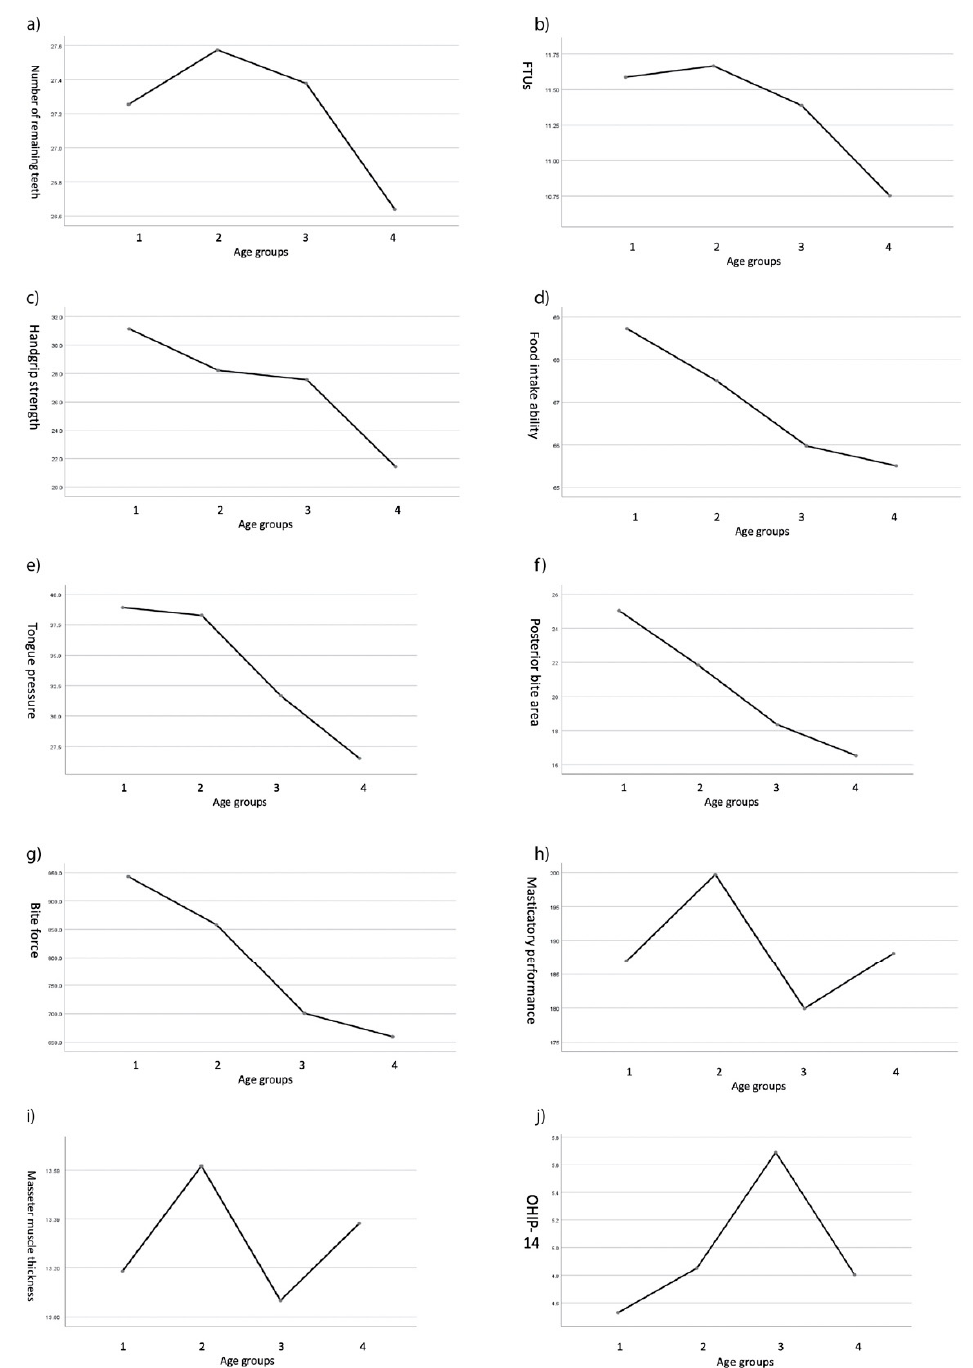
Figure A2. Changes of the variable in masticatory function among age groups. ( a ) the number of remaining teeth. ( b ) functional tooth units. ( c ) handgrip strength. ( d ) FIA. ( e ) tongue pressure. ( f ) PBA. ( g ) bite force. ( h ) masticatory performance. ( i ) MMT. ( j ) OHIP-14.